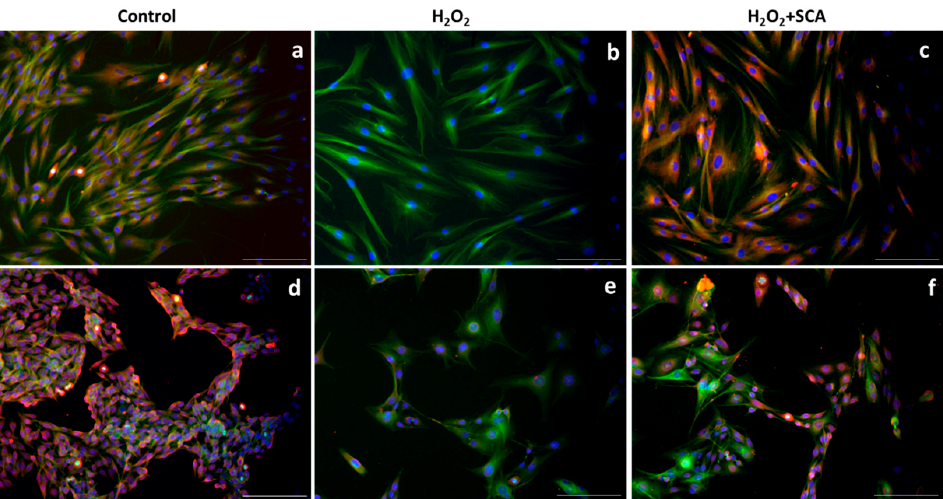
Figure 6. Treatment with SCA ® significantly promoted SIRT6 expression in senescent cells. Repre- sentative fluorescence microscopy images after SIRT6 (red) immunostaining. Green color shows cy- toskeleton staining with anti-a-tubulin, and nuclei were stained blue with Hoechst probe. Fibro- blasts ( a – c ) and B16-F10 cells ( d – f ) exposed to H 2 O 2 ( b , e ) and H 2 O 2 -exposed cells and treated with SCA ® ( c , f ). Scale bars: 200 µm.